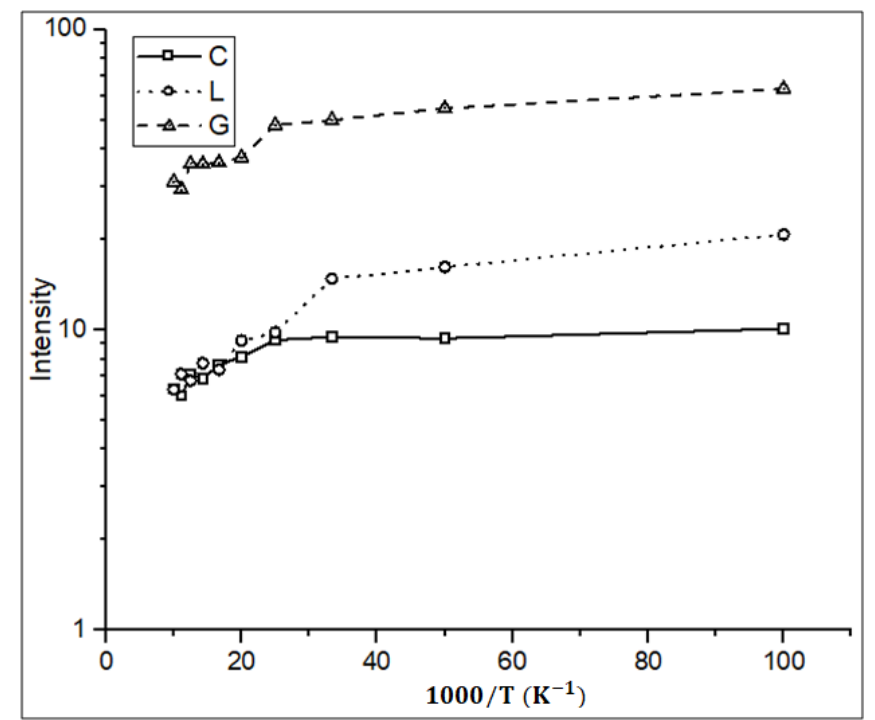
Figure 8. PL intensity of sample C, L and G at 1170 nm against 1000/T. Samples C and G are double implanted with 30/10 keV of carbon without boron implantation and with 10 keV of boron implant, respectively. Sample L is only implanted with 30 keV of boron. Laser power is 200 mW.